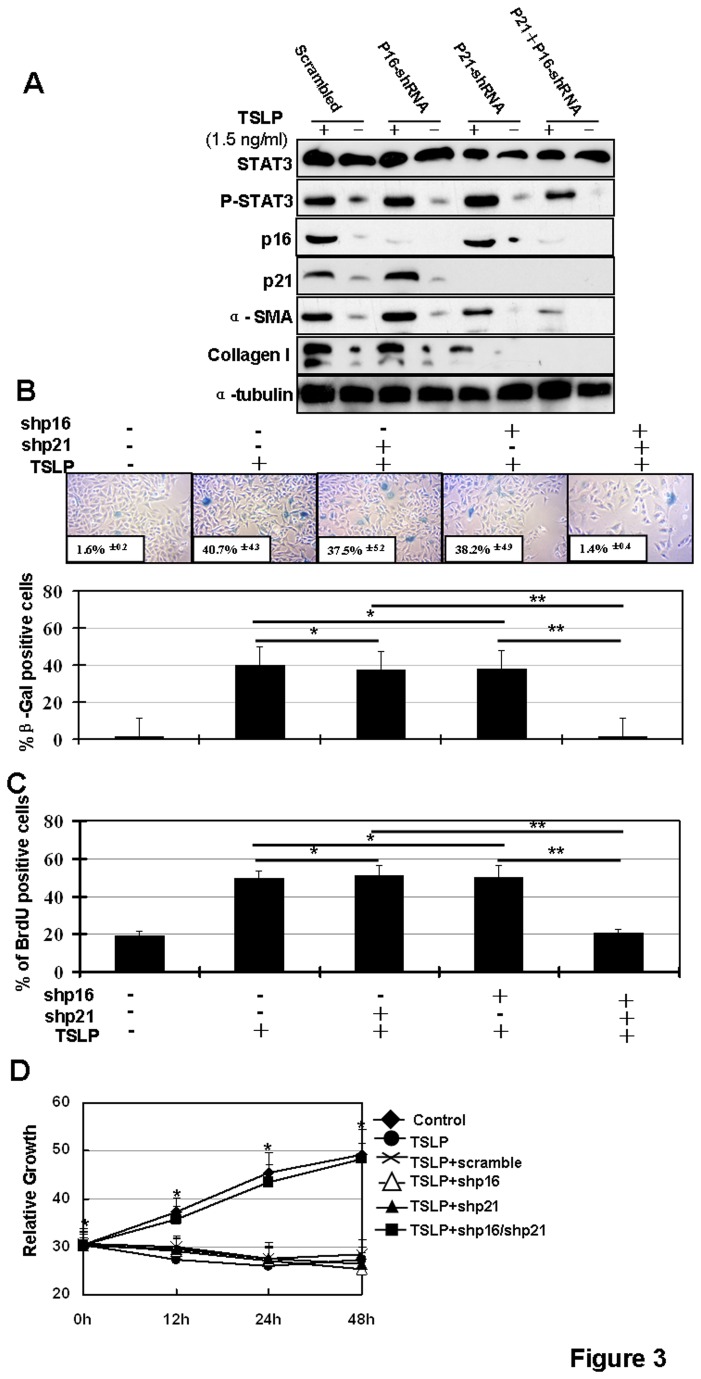
Senescent inhibition overcomes TSLP-induced airway remodeling in vitro.BEAS-2B cells with stable shp16, shp21 or both were incubated with TSLP (1.5ng/ml) for 6 h. (A) Cells were collected and total proteins were extracted and analyzed by western blotting. (B) Cells were fixed and stained with SA-β-gal (upper panel) and then positive SA-β-gal cells were quantified (*p>0.05, **p < 0.05) (low panel). (C) Cells were stained with BrdU (*p>0.05, **p < 0.05). (D) Senescent inhibition overcomes TSLP-induced cell growth inhibition in vitro. The relative cell number was detected to evaluate cell growth at different time points using MTT assays.